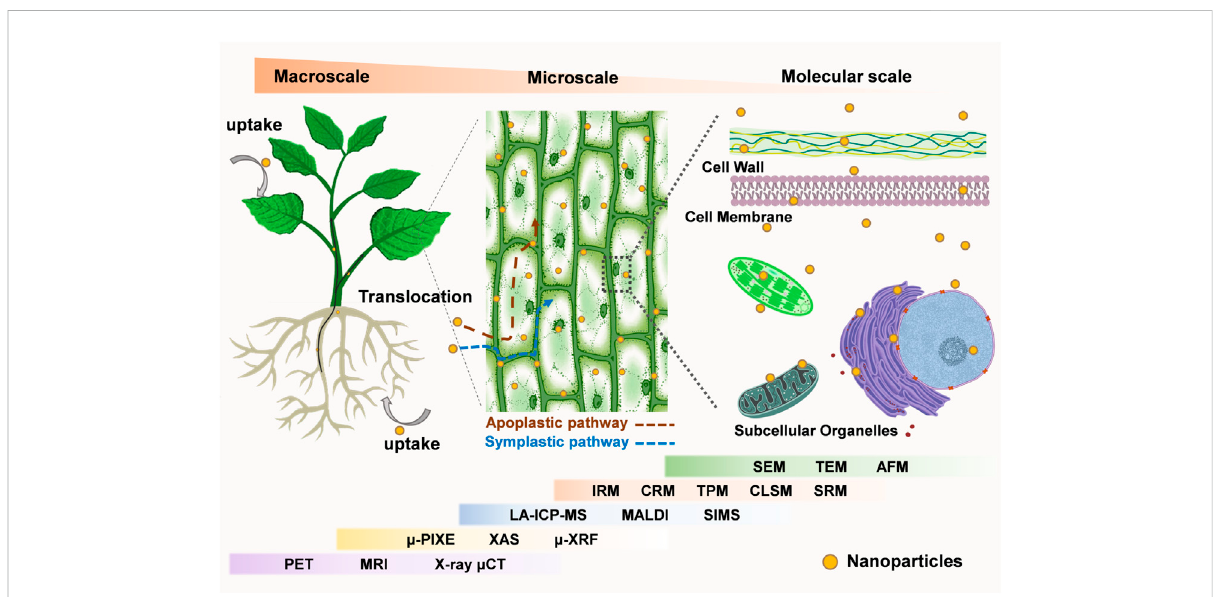
FIGURE 1 Imaging tools for plant nanobiotechnology at the micro-to-macro scale. At the microscopic scale, electron microscope (SEM, TEM, AFM) and opticalmicroscope(SRM,CLSM,TPM,CRM,IRM),XAS, μ -XRF,SIMScanbeusedtoobservetheinteractionofnanomaterialswithplantsatthecellular and subcellular levels. At the macroscopic scale, LA-ICP-MS, MALDI, μ -PIXE, PET, MRI, X-ray μ CT are used to observe the distribution of nanomaterials inspeci fi cplant organs, tissues and thewhole body. Meanwhile, some ofthe imaging techniques can be used for analysisacross micro and macro scales. (Abbreviations: SEM, Scanning Electron Microscope; TEM, Transmission electron microscopy; AFM, Atomic Force Microscopy; SRM, Super-resolution microscopy; CLSM, Confocal Laser Scanning Microscope; TPM, Two-photon microscopy; CRM,